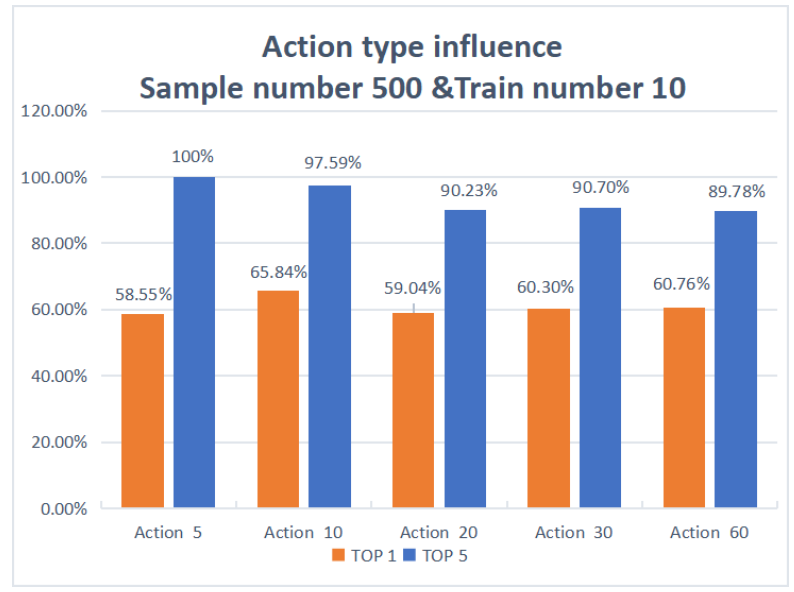
Figure 8. Histogram of the impact of action